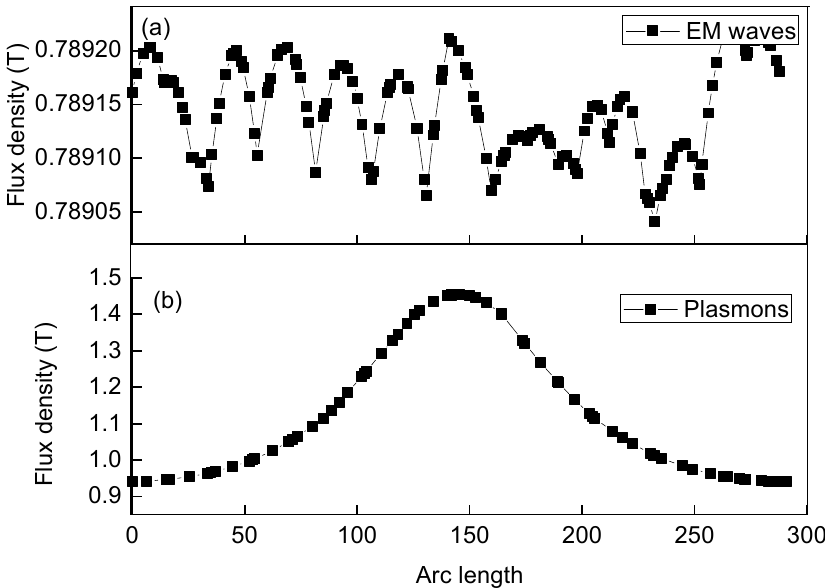
Figure 1. The computed flux density in case of 340 nm wavelength incident light as a function of arc length for EM waves and plasmons. ( a ) Flux density across geometry for incident light ( b ) Flux density in region of plasmons formation.